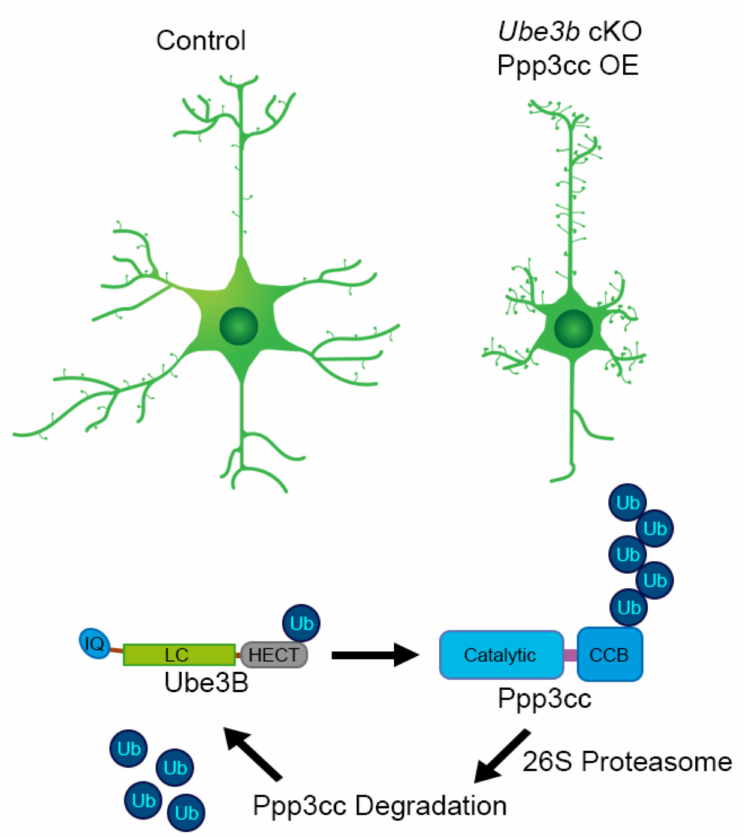
Figure 4. Ube3b-mediated Ppp3cc regulation. In the forebrain-specific Ube3b cKO mouse, cortical and hippocampal neurons exhibit simpler, less arborized dendritic trees. This phenotype is mimicked, once neurons overexpress gamma-subunit of calcineurin, Ppp3cc, ubiquitination substrate of Ube3b. LC, low complexity; CBB, calcineurin B and calmodulin binding. PolyUb chain on position on Ppp3cc is randomly placed on the scheme to depict Ube3b-mediated